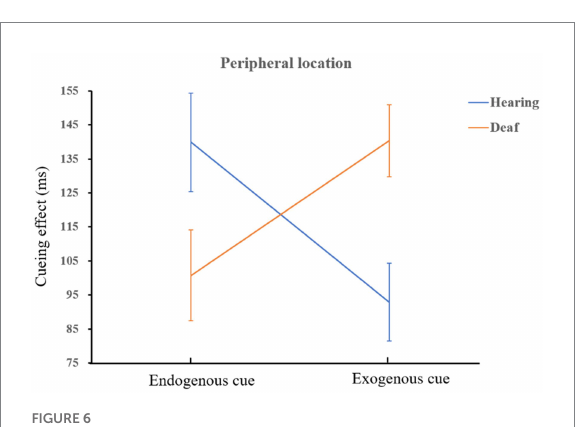
FIGURE 6 The interaction of group and cue type when stimulus is presented in peripheral location.